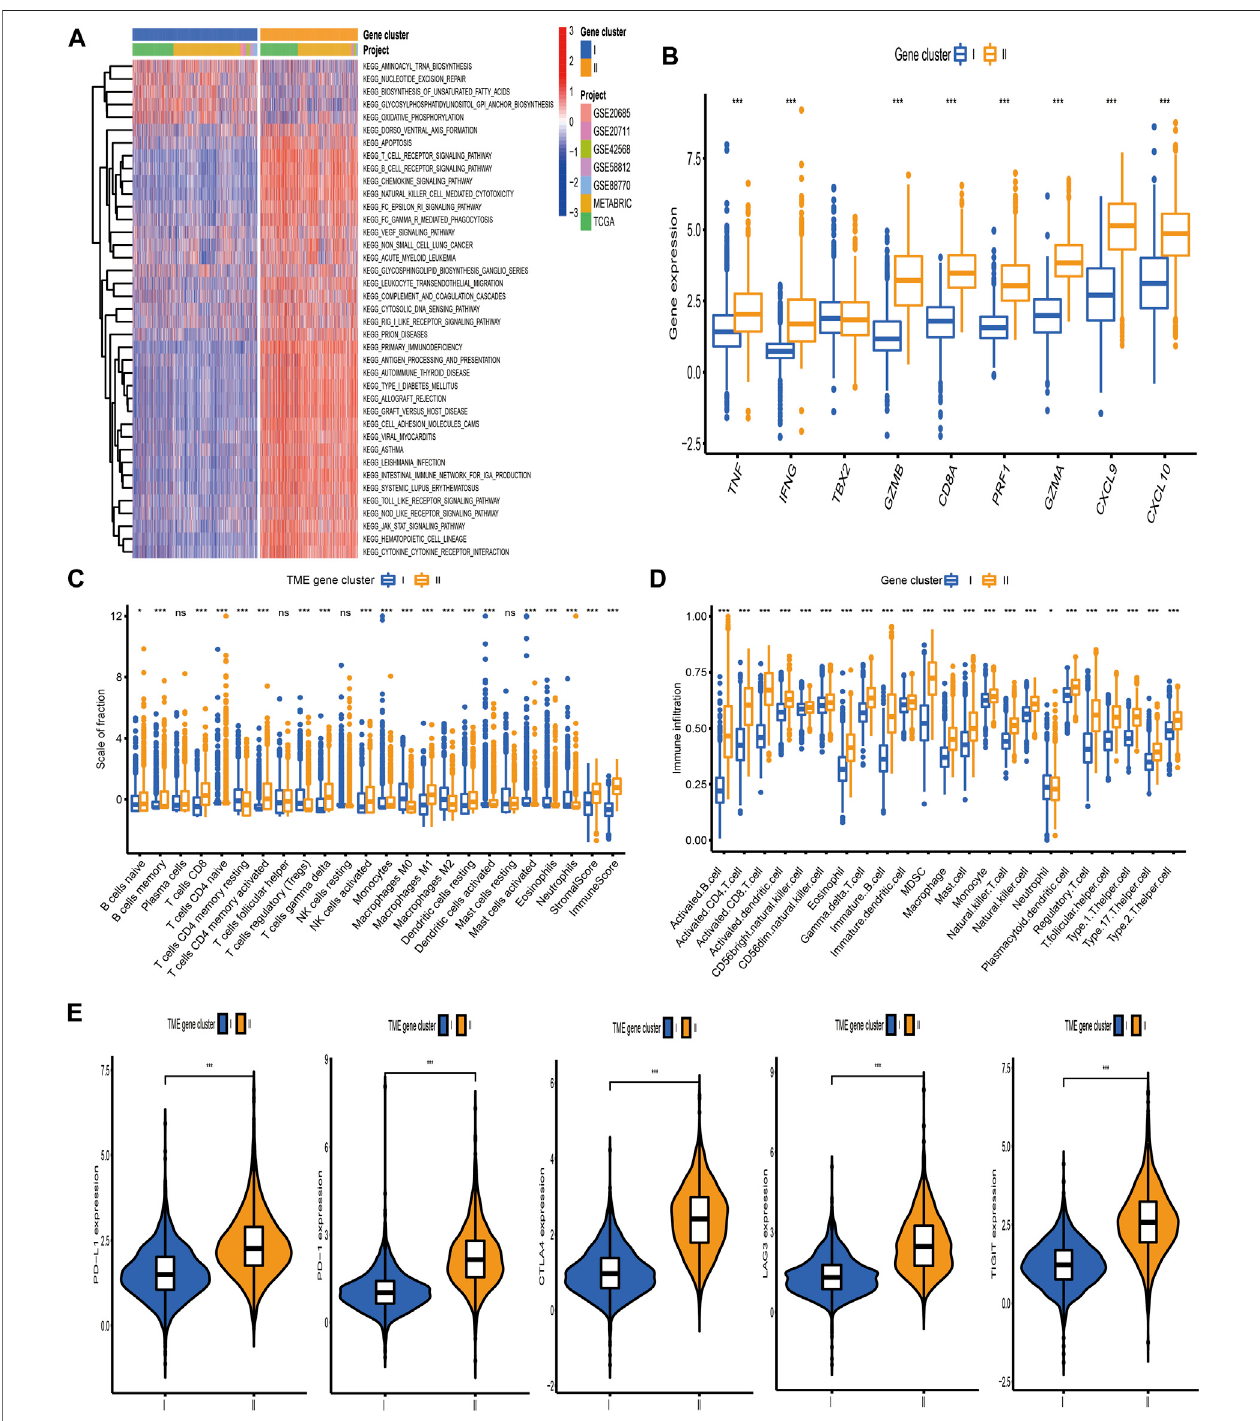
FIGURE 5 | Biological pathways and tumor microenvironment characteristics in distinct gene clusters. (A) Heatmap showed the GSVA score of representative hallmark pathways curated fromMSigDB betweendistinctTMEgeneclusters. (B) Thedifferences inmRNAexpression oftranscripts associatedwithimmune activation between distinct gene clusters. (C, D) The fraction of tumor-in fi ltrating immune cells between distinct gene clusters using the CIBERSORT and ssGSEA algorithms. Within each group,thescattered dotsrepresentedTMEcellexpression values.Thethicklinerepresented themedian value.Thebottomandtop oftheboxeswere the25thand75thpercentiles(interquartilerange),respectively.Thestatisticaldifferenceofthethreegeneclusterswascompared throughtheKruskal – WallisHtest.* p < 0.05; ** p < 0.01; *** p < 0.001. (E) Comparison of the expression level of immunosuppressive molecules between distinct TME gene clusters.